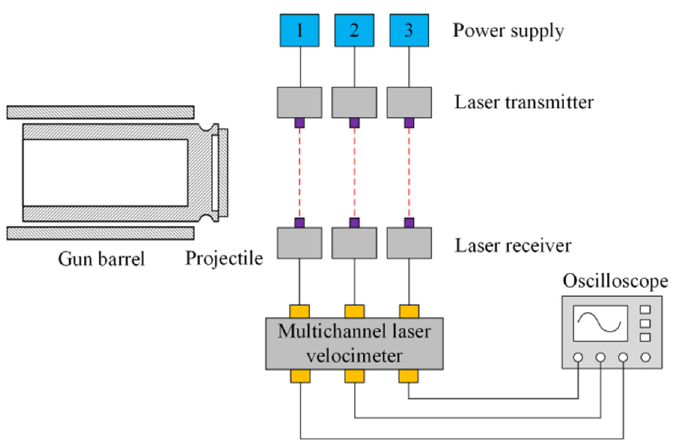
Figure 17. Schematic diagram of optical beam blocking.